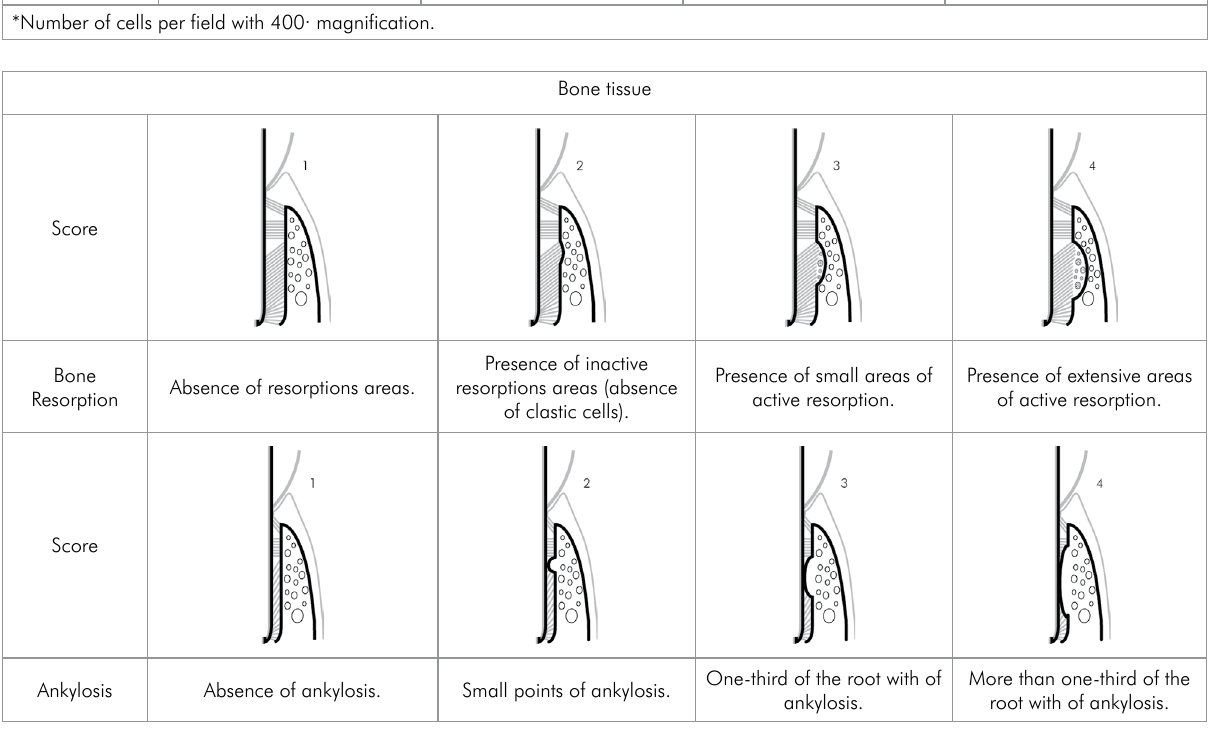
Figure 1. (Continuation) Scores used in the quantification of histological